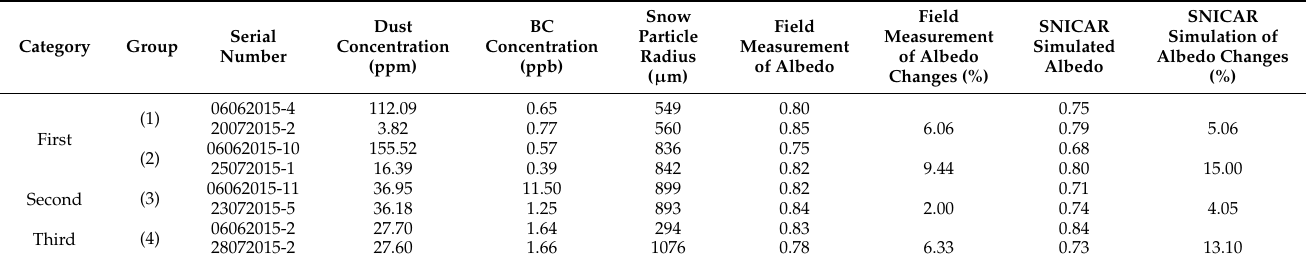
Table 2. Comparison between the effects of dust concentration, BC concentration, and snow particle size on albedo, as determined by field measurements and